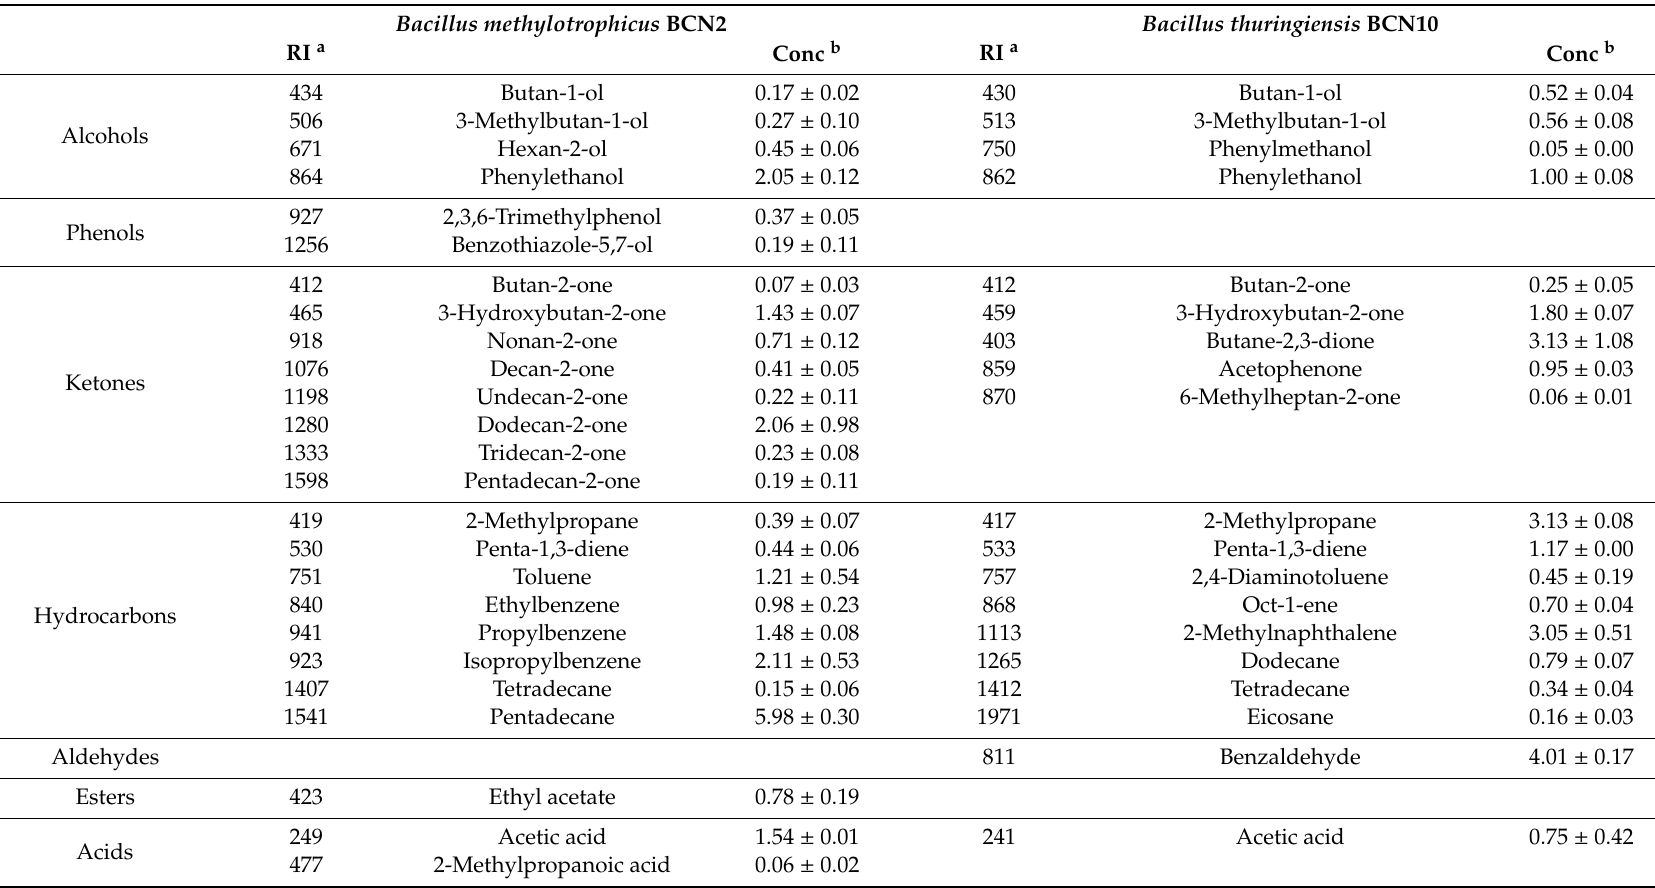
Table 2. Volatile compounds detected in the headspace from the Bacillus cultures inoculated in LB culture vial at 37 ◦ C for 12